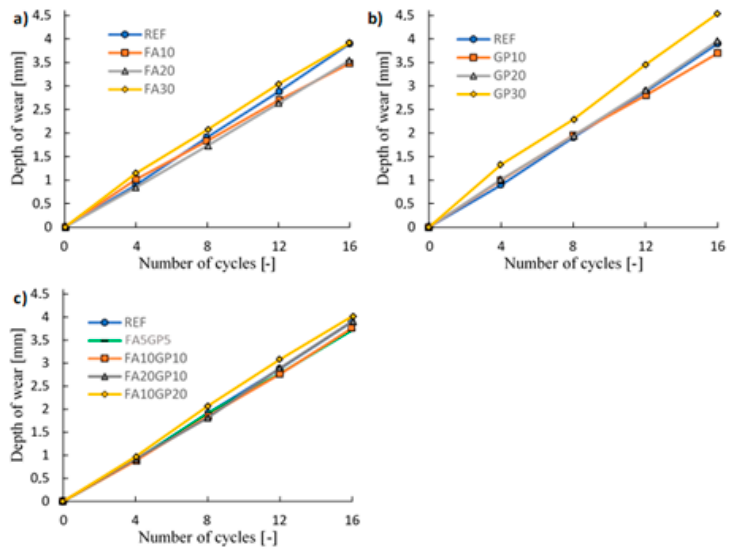
Figure 5. The results of the depth of wear as a function of the number of cycles for samples with ( a ) fly ash, ( b ) granite powder, and ( c ) fly ash and granite powder.